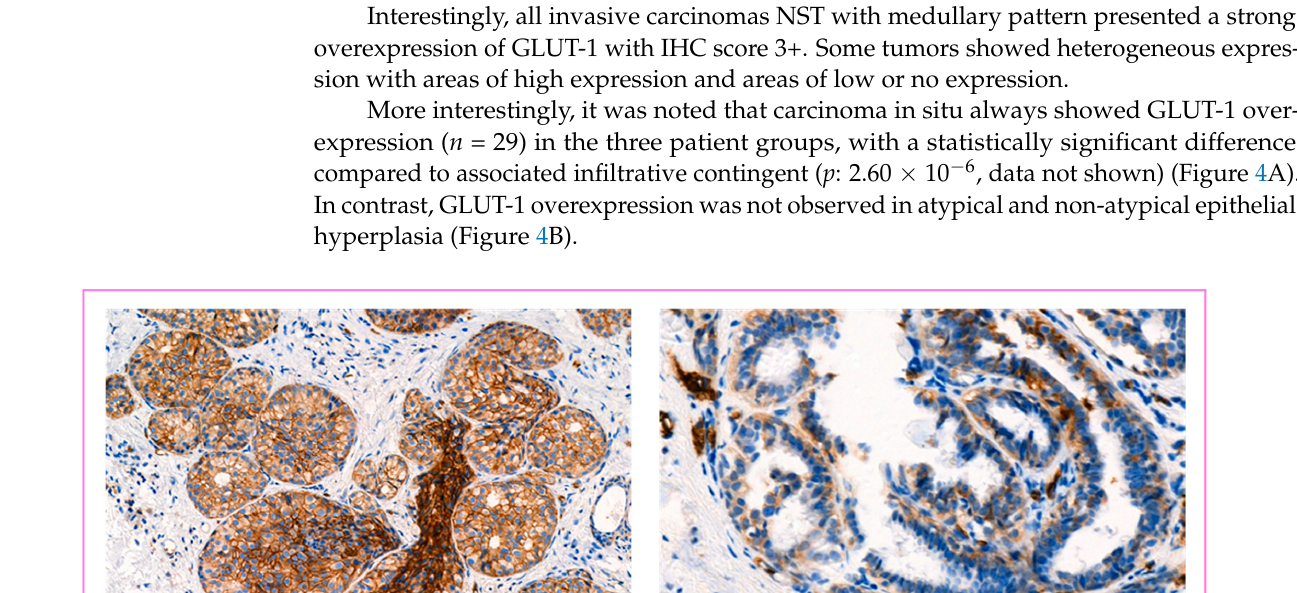
Table 7. Comparison of clinicopathological data with GLUT-1 expression ( n = 144). GLUT-1 Overexpressing